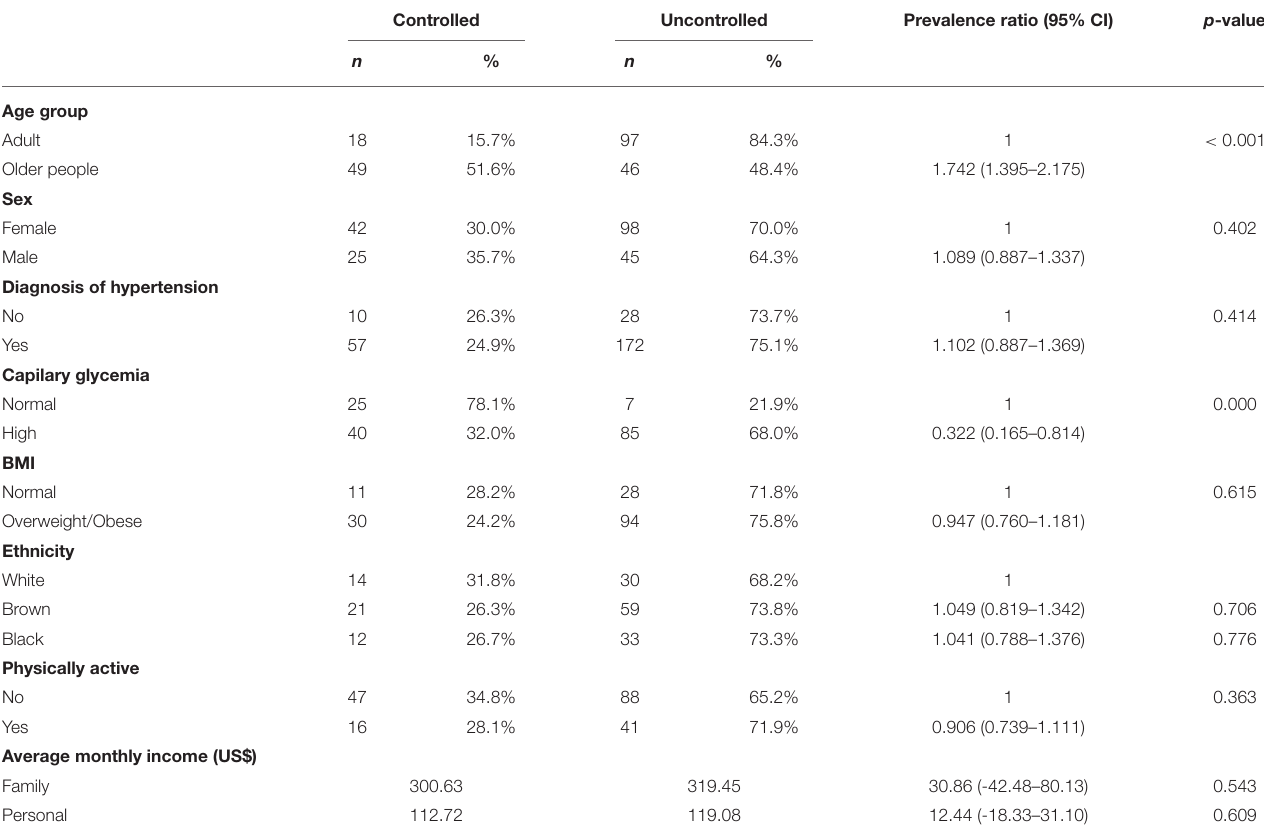
TABLE 2 | Comparison of the characteristics of the participants with a previous diagnosis of diabetes according to the glycemic status assessed using the HbA1c point-of-care test.